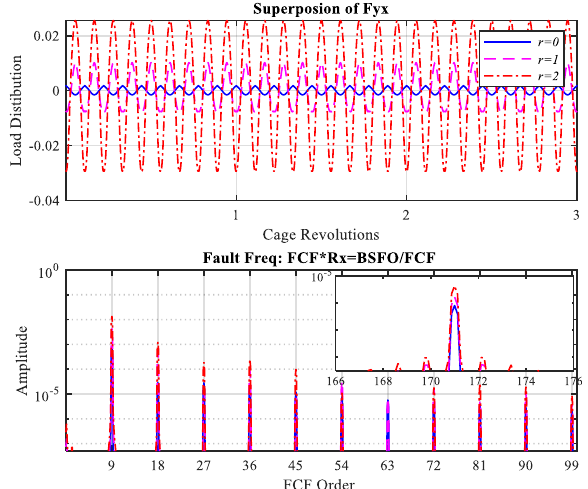
Figure 5. Dynamic force waveforms and spectrum for error-free